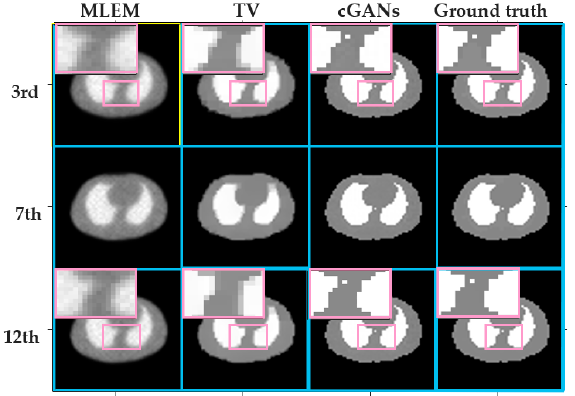
Figure 8. Reconstruction results for Zubal thorax phantom with 40 min scanning and 1 × 10 7 counts. From left to right: MLEM results, TV results, cGAN results, and ground truth. From top to bottom: the 3rd, 7th, and 12th frames.